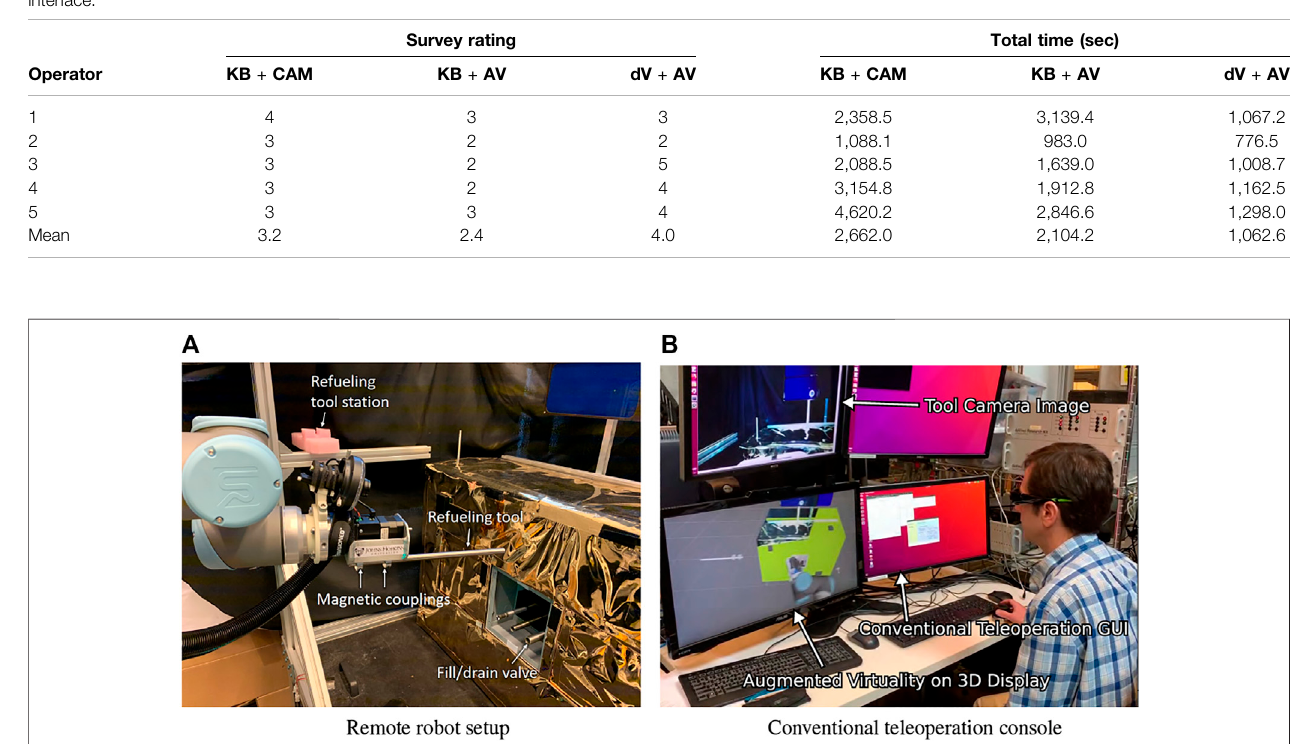
FIGURE13| IPSEtestsetup. (A) Space-sidesetupwithmocksatellite,mockservicingrobot,andrefuelingtoolstation; (B) Conventionalteleoperationconsolewith 3D monitor for augmented virtuality visualization (note that operator is wearing shutter